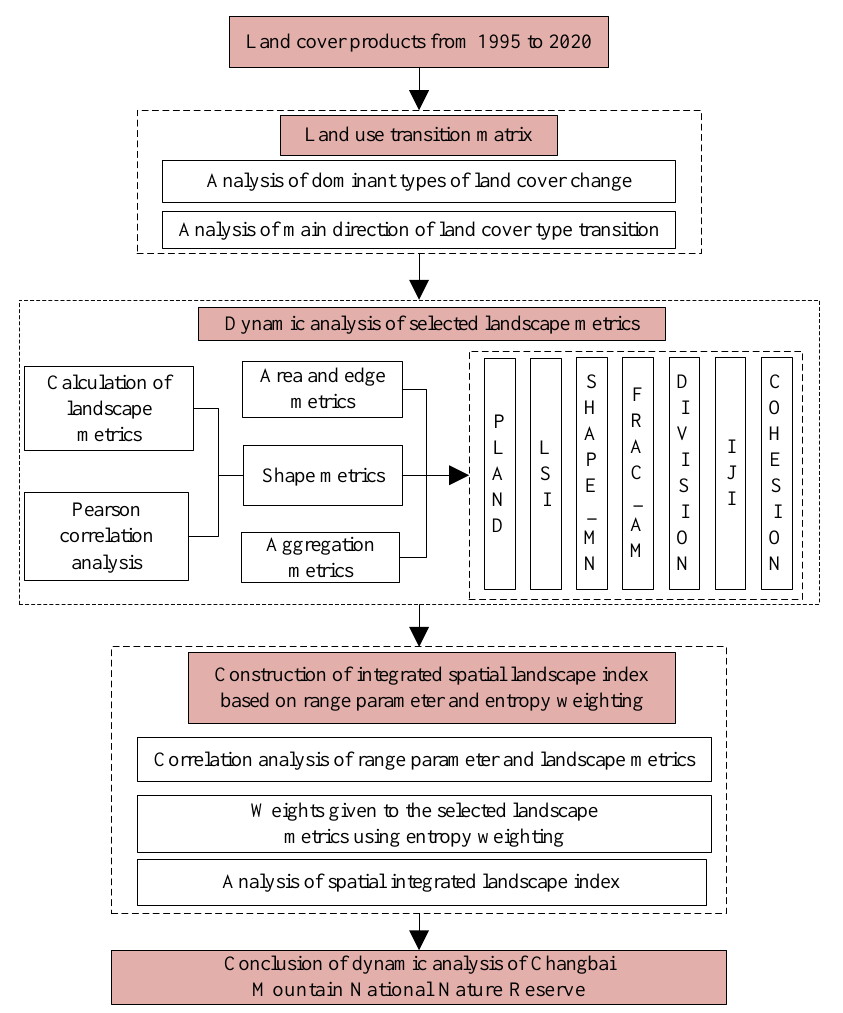
Figure 3. Technical Flow Chart.